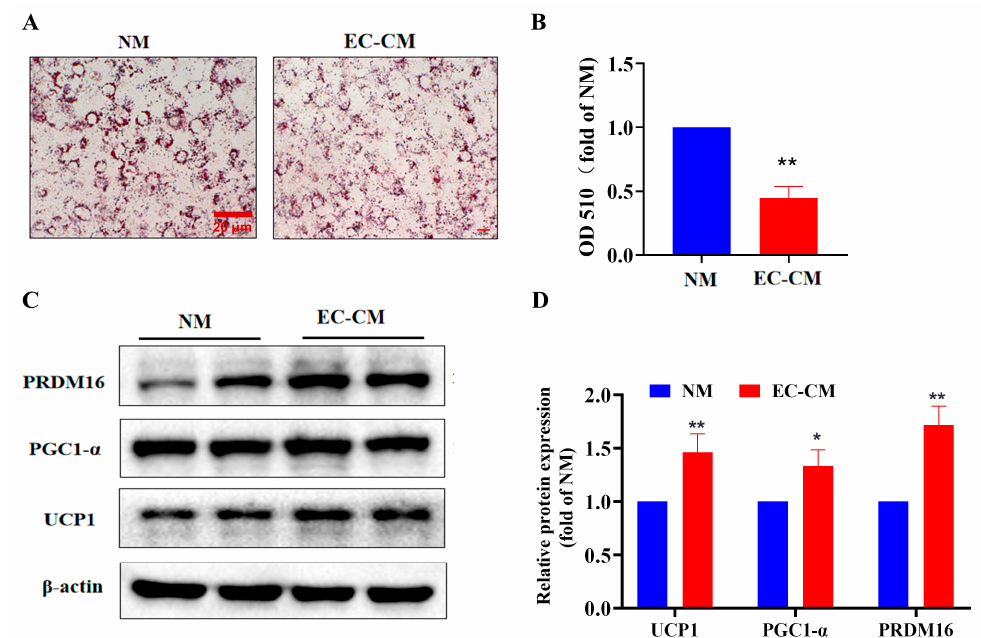
Figure 5. Effect of EC-CM on lipid aggregation and browning in vitro, where 80% of confluent 3T3-L1 adipocytes were treated with EC-CM or NM for 48 h. Lipid accumulation was detected by oil red O staining ( A , B ). Expression levels of browning-related proteins, including UCP-1, PGC1- α and PRDM16 ( C , D ), were analyzed by Western blots. Data are presented as mean ± SEM from three independent experiments ( n = 3). An unpaired two-tailed Student’s t -test was used. * p < 0.05, ** p < 0.01, vs. the NM group. EC-CM: conditional medium from endothelial cells; NM: normal high-glucose DMEM completed medium. Scale bar in the images of ( A ): 20 µ m. ASP : asprosin, UCP1: uncoupling protein 1, PGC1- α : PPAR gamma coactivator 1, PRDM16: PRD1-BF-1-RIZ1 homologus domain-containing protein-16.